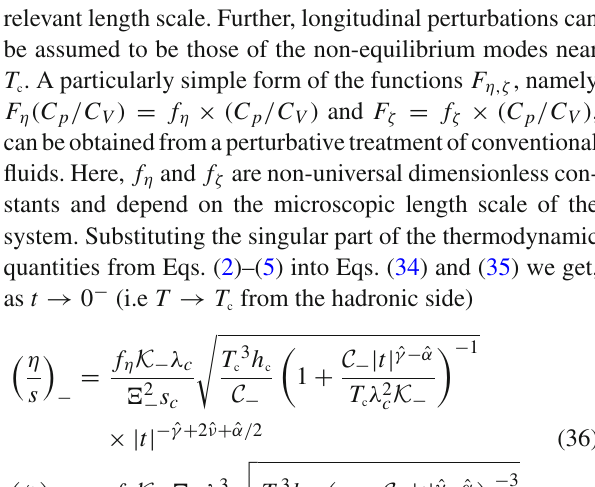
Table1 Parametersofthecontinuouspartofthedensityofstates,taken fromRefs.[36,48].AccordingtothediscussioninSect.2,theparameter b is set to the inverse of T c , whose value is T c = 0 . 160 GeV. Note that the value of A 1 chosen for the ρ 1 model corresponds to A 1 = 15 T 3 discussed in the text density of